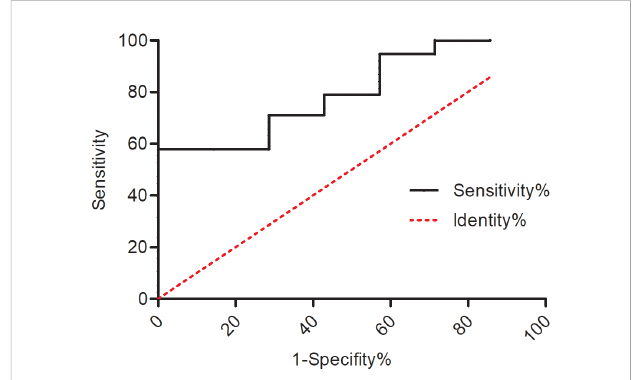
FIGURE 2 ROC curve of the predictive value of Cho/Cr for H3K27 alteration status ( P = 0.012, cutoff value = 2.38, AUC =